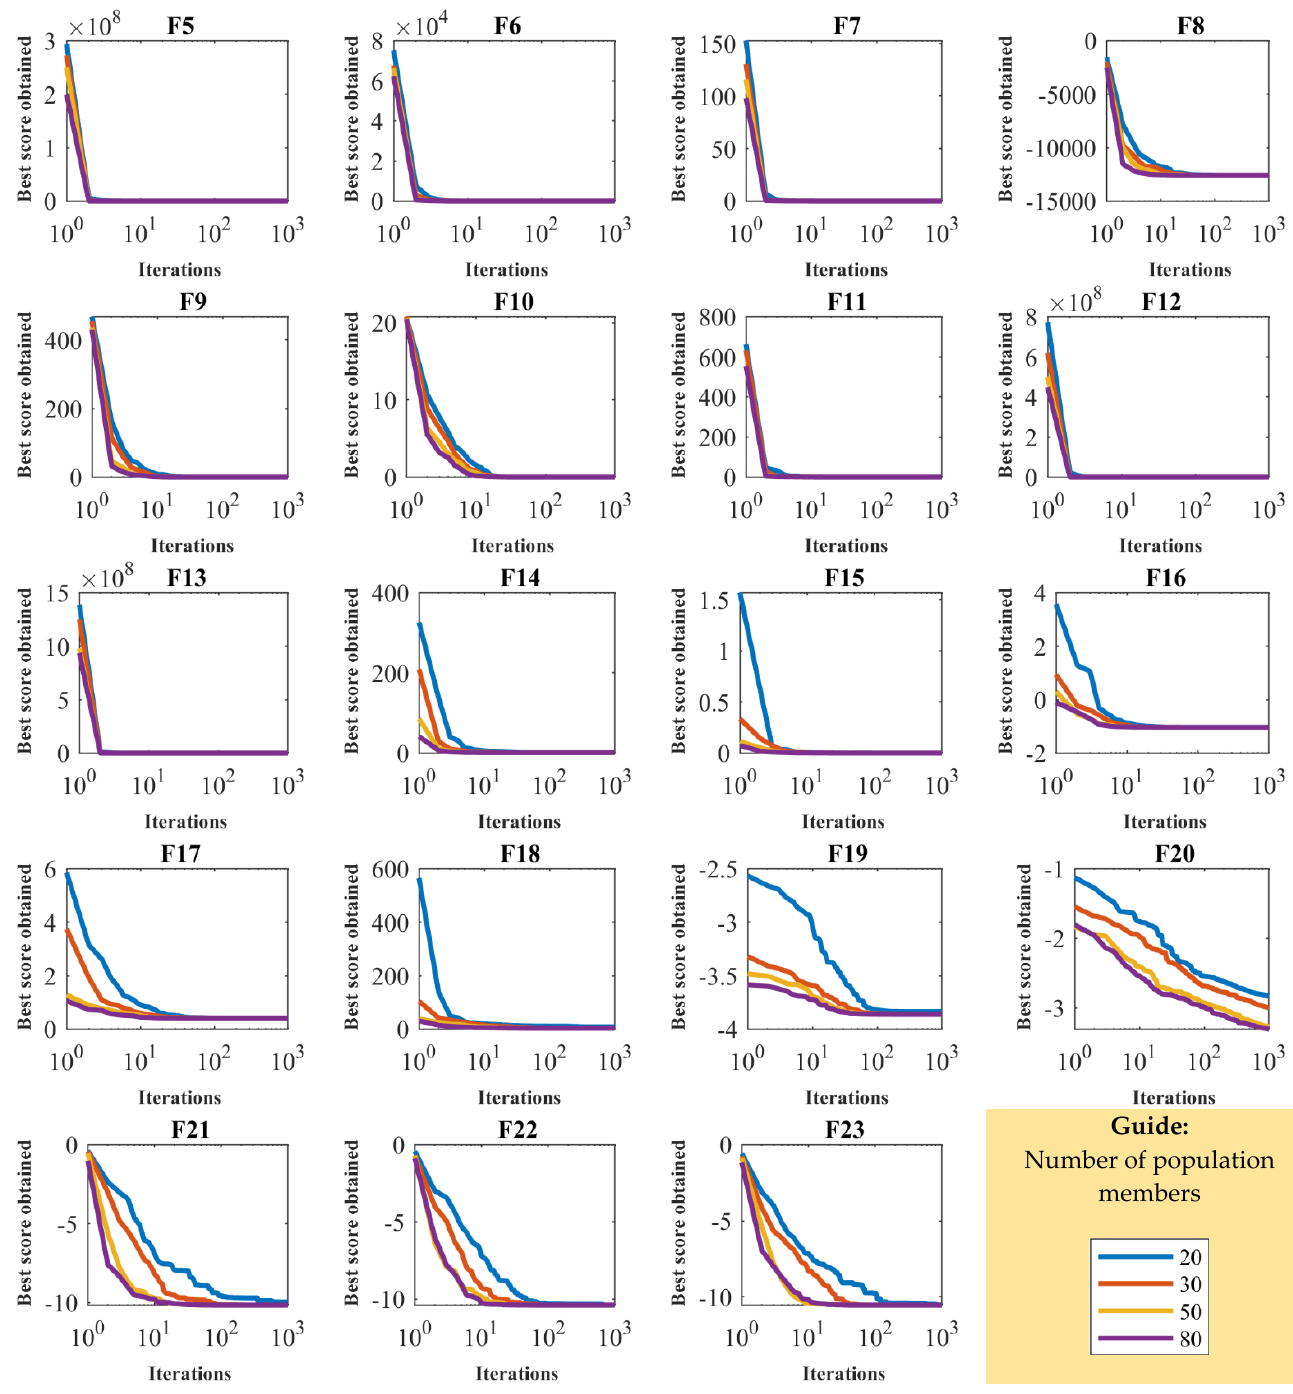
Figure 4. Sensitivity analysis of the SSVUBA for the number of population members.